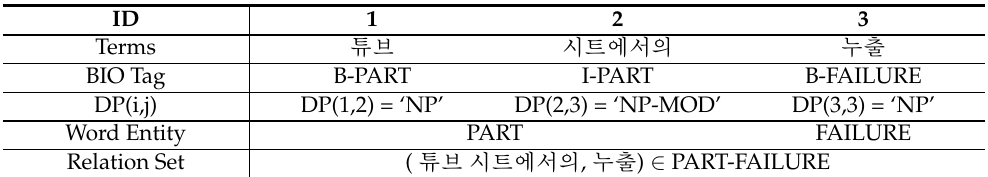
Table 3. An example of the results by applying Rule #1.